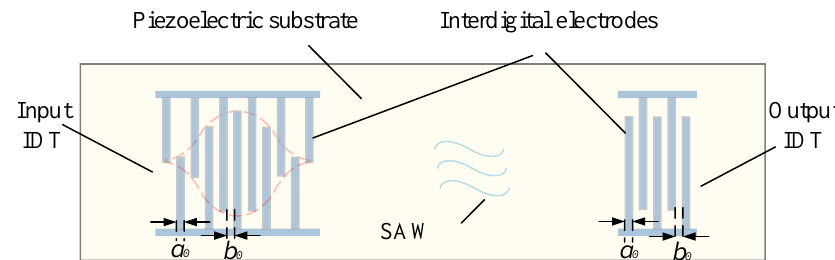
Figure 1. Structure diagram of the SAW sensor.